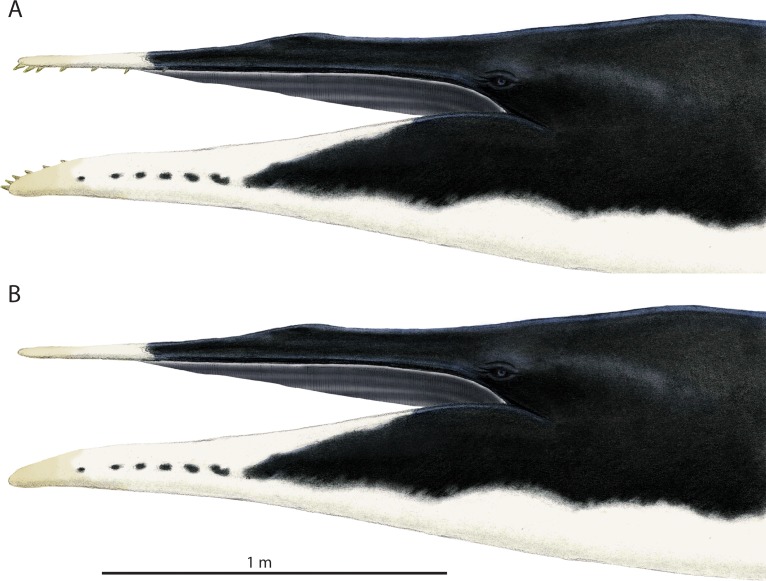
Alternative life restorations of Waharoa ruwhenua.(A) with erupted permanent dentition; (B) without dentition.